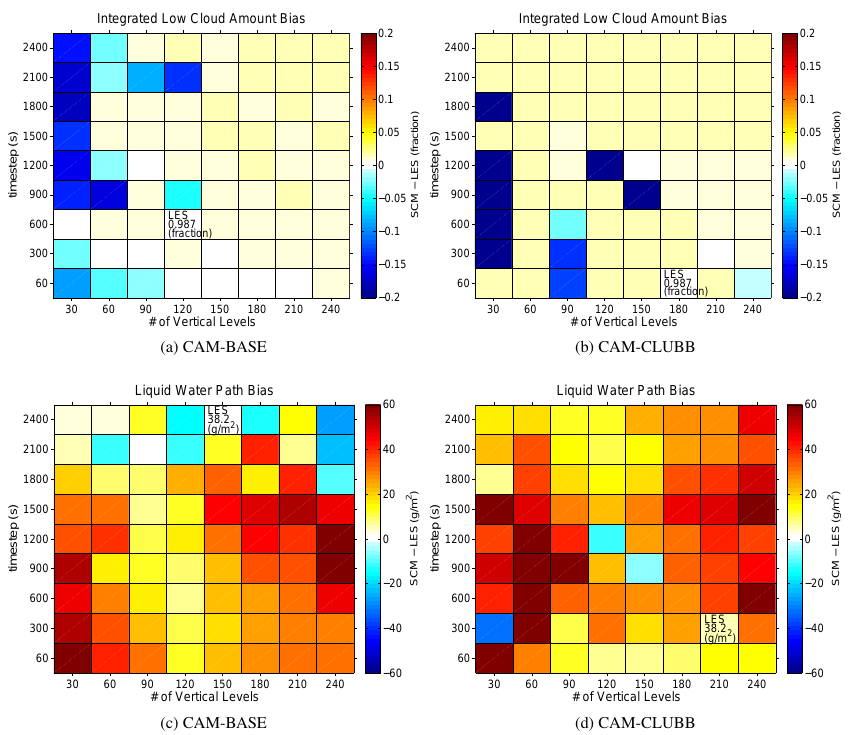
Fig. 8: Same as Fig. 1 except averaged over hours 4–6 of the simulation for the DYCOMS2-RF01 case of maritime stratocumulus.